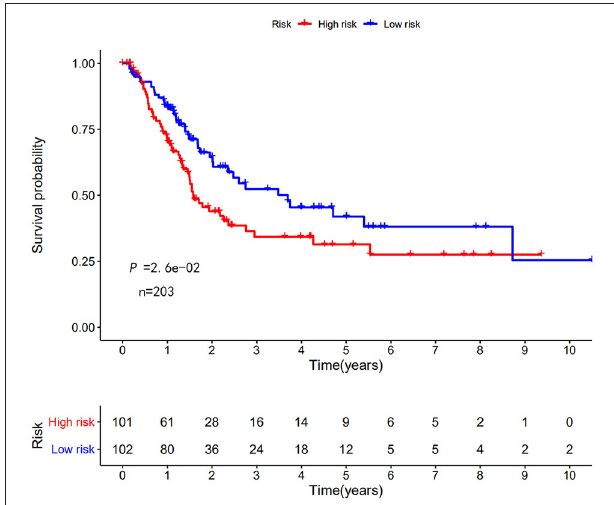
FIGURE 7 | KM survival curve of the autophagy-related lncRNA risk score for BC in TCGA testing group. TCGA data shows that the 5-year survival rate of high-risk patients is lower than that of low-risk patients (log rank p < 0.01).